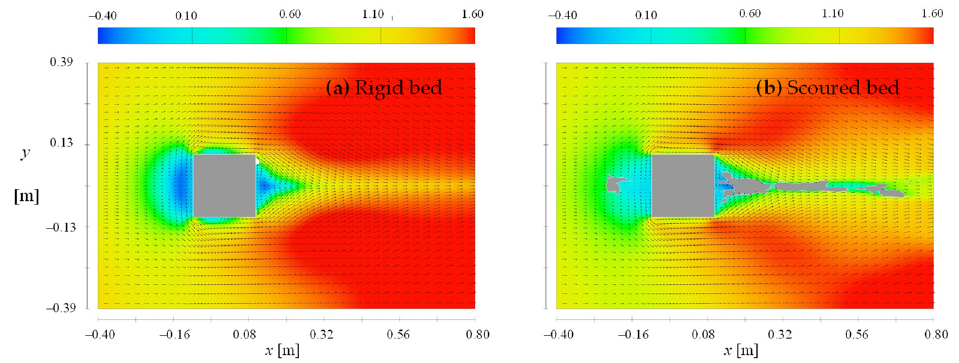
Figure 11. Horizontal flow field around the structure at the plane near the bottom bed under the conditions of ( a ) rigid bed and ( b ) scoured bed.